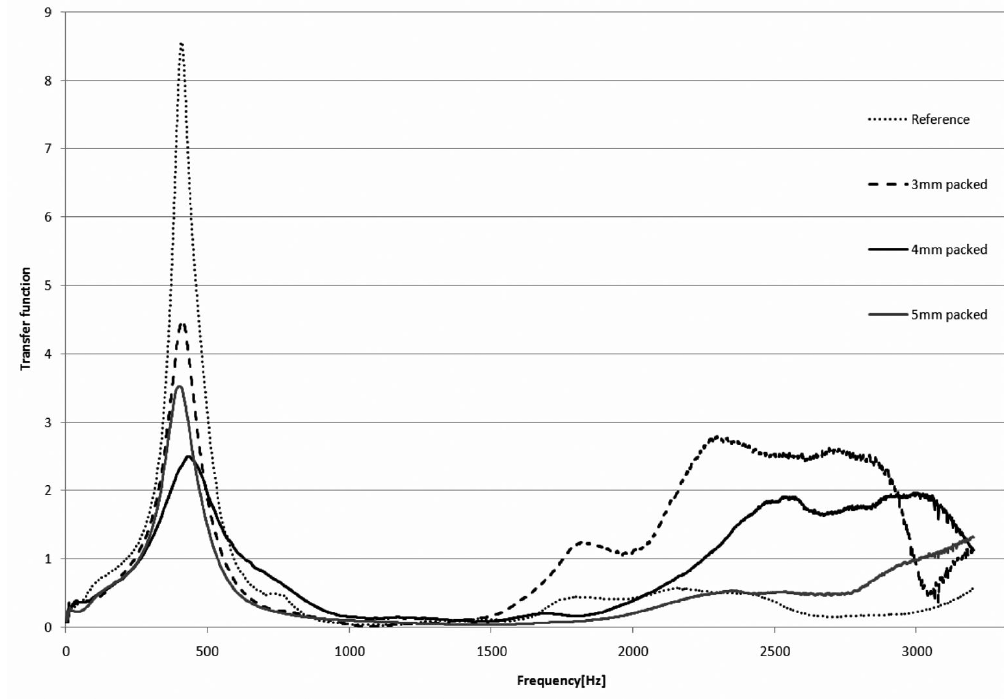
Fig. 65. EIDL Transfer function curves – Packed vs. Reference.